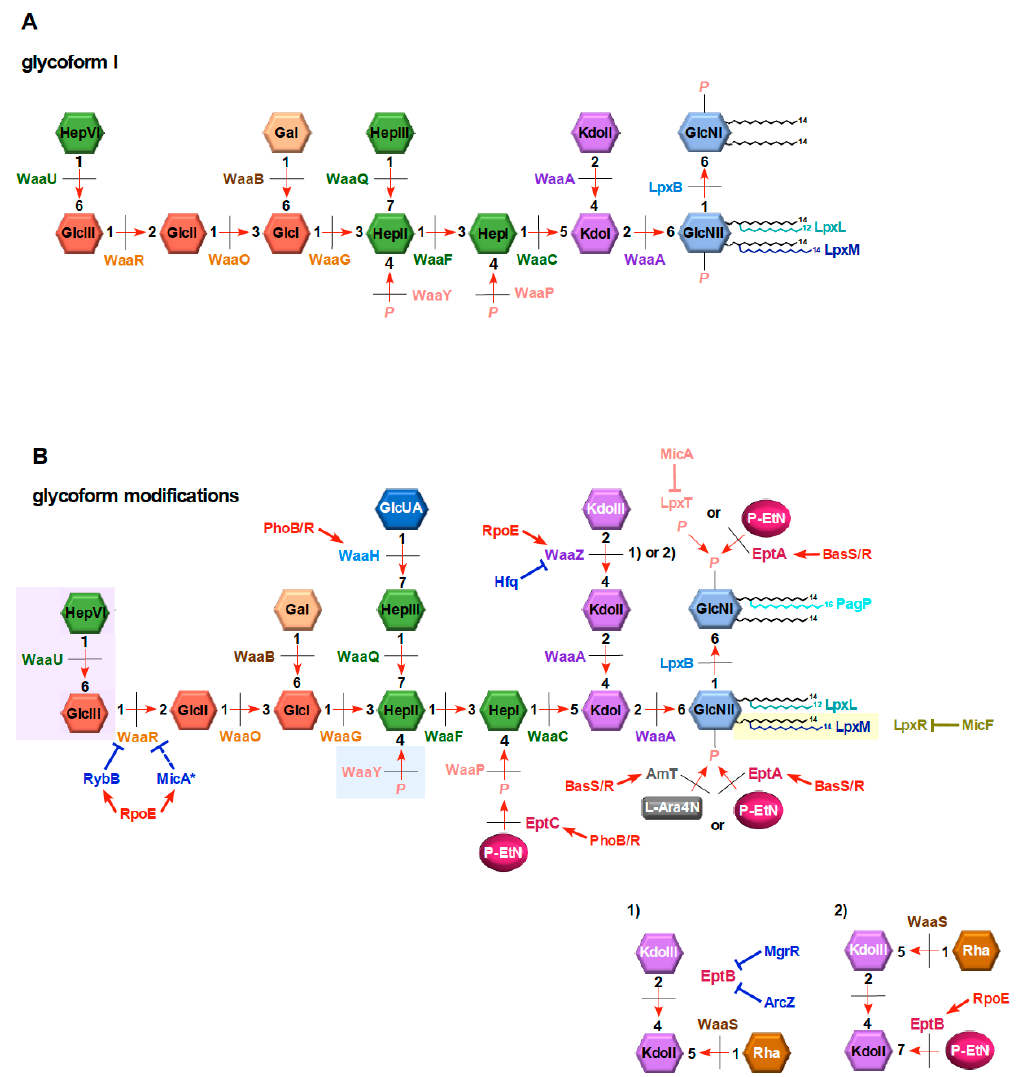
Figure 2. Schematic depiction of unmodified hexaacylated glycoform I and glycoform derivatives with various non-stoichiometric substitutions with a third Kdo-Rha disaccharide. Various genes whose products mediate different steps in LPS biosynthesis and incorporation of different modifications are indicated. Glycoform I constitutes the major LPS species under non-stress conditions ( A ). Upon the induction of RpoE sigma factor and conditions inducing BasS/R and PhoB/R TCSs, the lipid A part is modified by P-EtN and L -Ara4N at 1 and 4’ position by EptA and ArnT, respectively ( B ). The induction of RpoE causes increased synthesis of EptB overcoming MgrR silencing and incorporation of P-EtN on the second Kdo (panels B1 and B2). The induction of RpoE favors pathway of the third Kdo incorporation by increased synthesis of WaaZ and repression of WaaR by the RybB sRNA, leading to synthesis of glycoforms with a third Kdo with attachment of Rha on the third Kdo with a concomitant truncation of the terminal GlcIII-HepIV disaccharide shown in violet background. The PhoB/R induction leads to the incorporation of GlcUA at the expense of HepII phosphorylation (blue background). Lipid A can also be modified by PagP generating heptaacylated lipid A and by the removal of acyl chains by LpxR in the OM after translocation (light brown background). Various sRNA-mediated controls are shown in blue color.